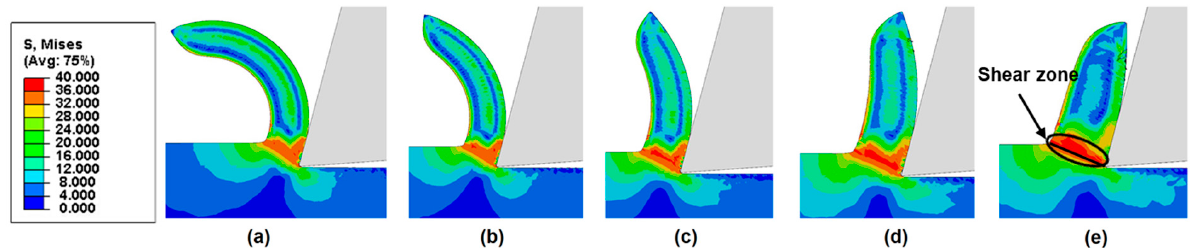
Figure 13. Chip morphologies (cutting depth = 180 µm) predicted by FE model with a rake angle of 15° when friction